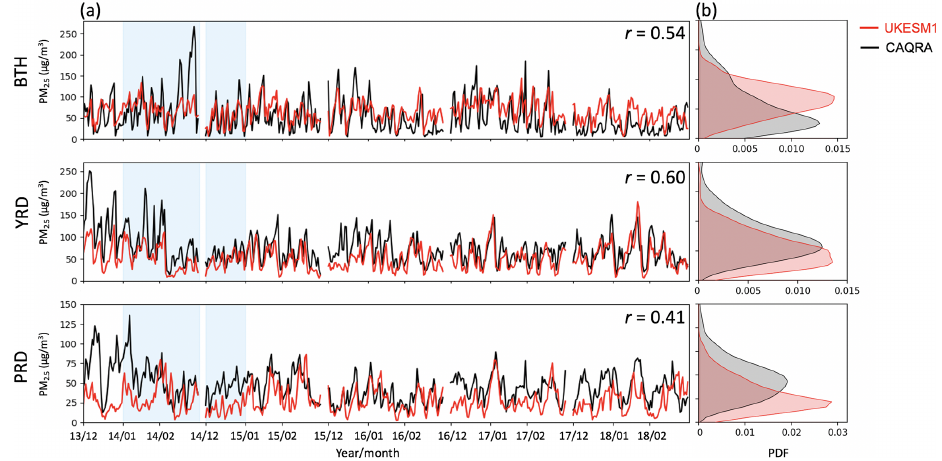
Figure 3. Comparison of daily mean PM 2 . 5 concentrations (µgm − 3 ) provided by UKESM1 and CAQRA for BTH, YRD, and PRD during DJF 2013–2017. (a) Time series of daily mean PM 2 . 5 concentrations. Blue area represents JFD 2014. The values of the Pearson correlation coefficients ( r ) of the daily time series for all days in DJF 2013–2017 are also displayed. All correlation values are significant at the 99% confidence level using a two-tailed Student’s t test as indicated in von Storch and Zwiers (1999). (b) Frequency distributions of the daily mean PM 2 . 5